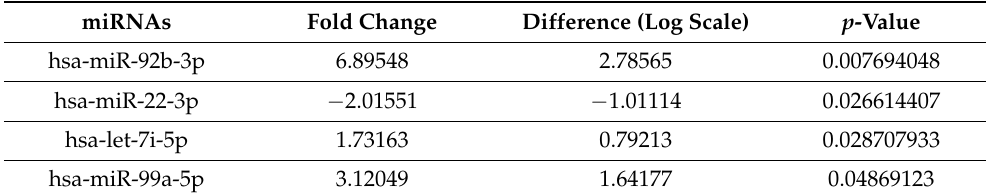
Table 2. Four miRNAs were differentially expressed between T2DM patients with and without corneal nerve loss.